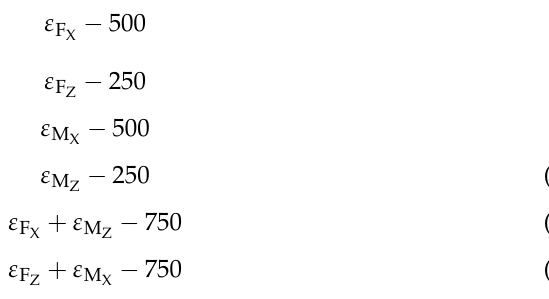
Table 3. Result of optimization with different pure loads and multiple